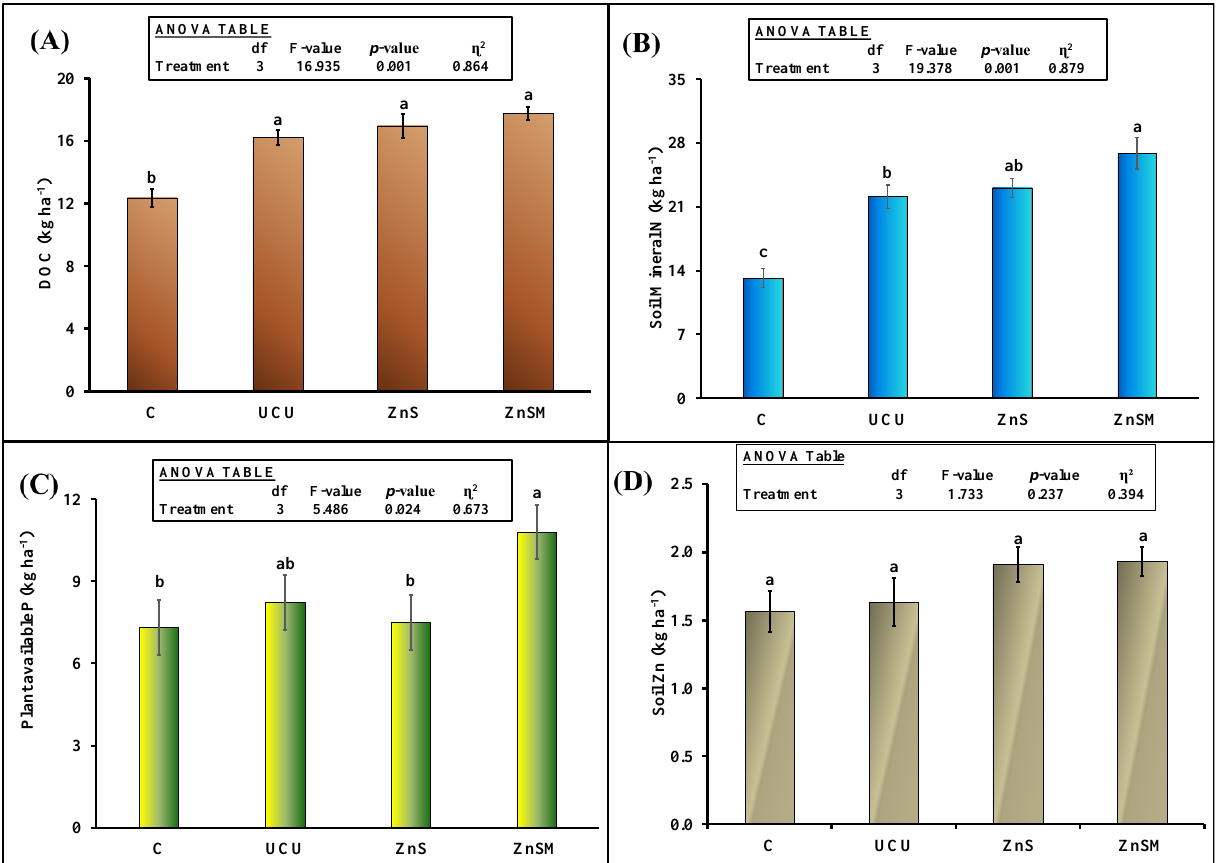
Seed and root dry matter yield did not differ between control and uncoated urea treat-